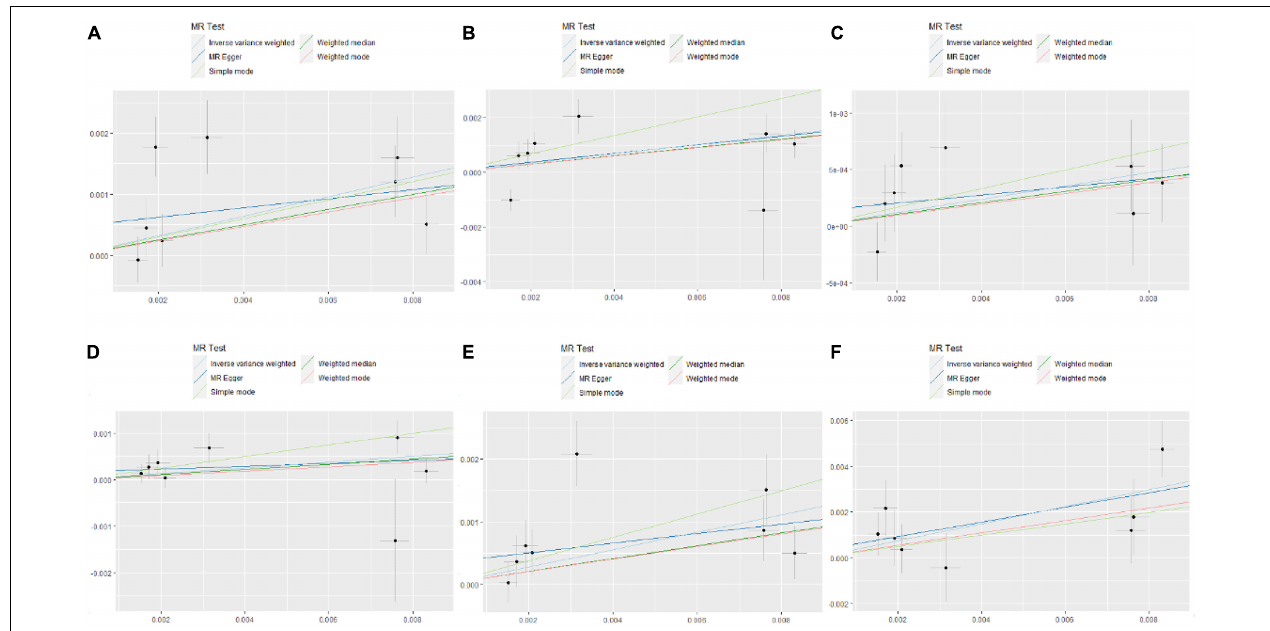
FIGURE 2 | MR tests of RA with angina, hypertension, heart attack, abnormalities of heartbeat, stroke, and coronary heart disease. The estimate of intercept can be interpreted as an estimate of the average pleiotropy of all single-nucleotide polymorphisms (SNPs), and the slope coefficient provides an estimate of the bias of the